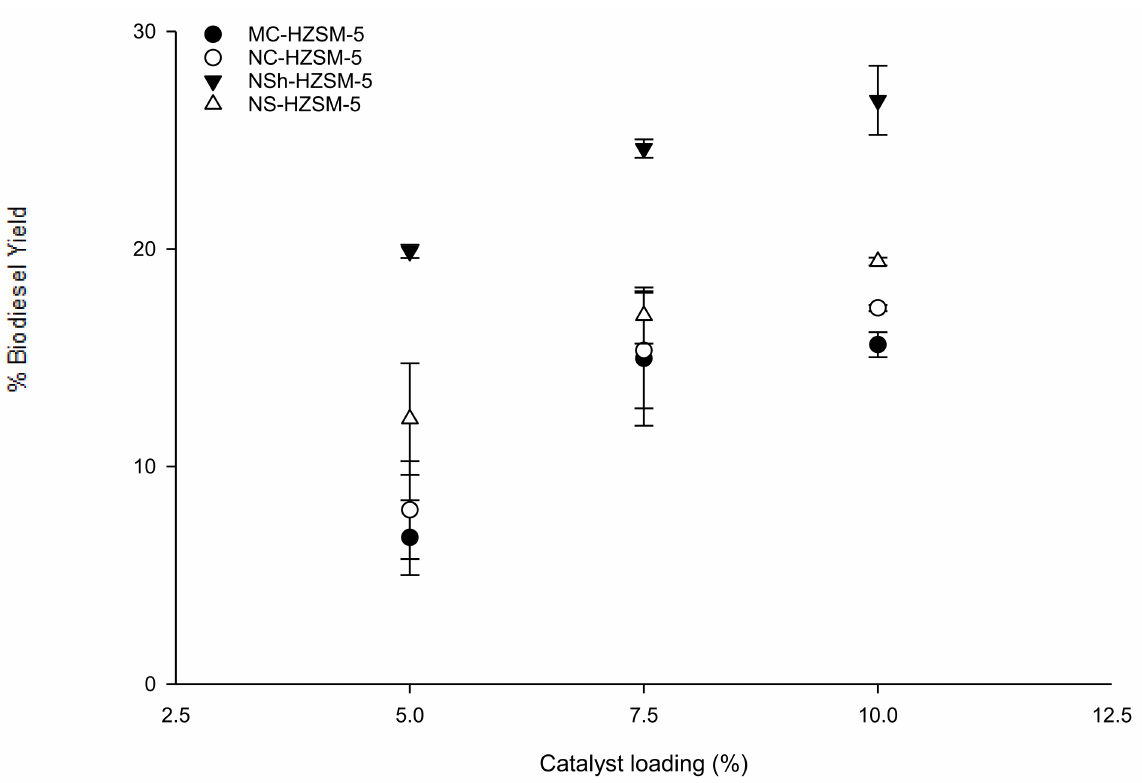
Figure 6. Effect of MC-HZSM5, NC-HZSM5, NSh-HZSM5, and NS-HZSM5 catalysts loading on the transesterification of WFO at the molar ratio of methanol to WFO of 12:1, 140 ◦ C, 550 rpm, and 6